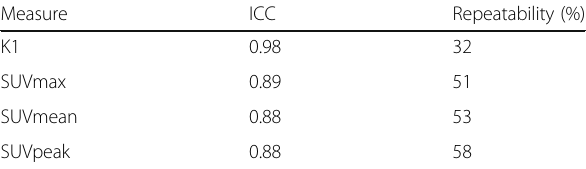
Table 2 Descriptive test-retest statistics. ICC intraclass coefficient Measure